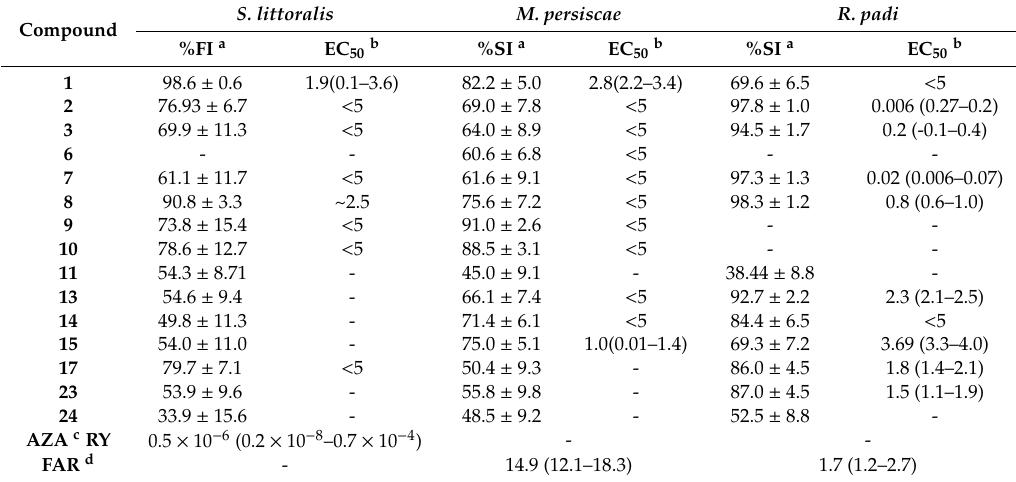
Table 3. Antifeedant e ff ects of germacrone derivatives against S. littoralis , M. persicae and R. padi . E ff ective doses (EC 50 in mg / mL) have been included for the positive controls azadiractin (AZA) and farnesol